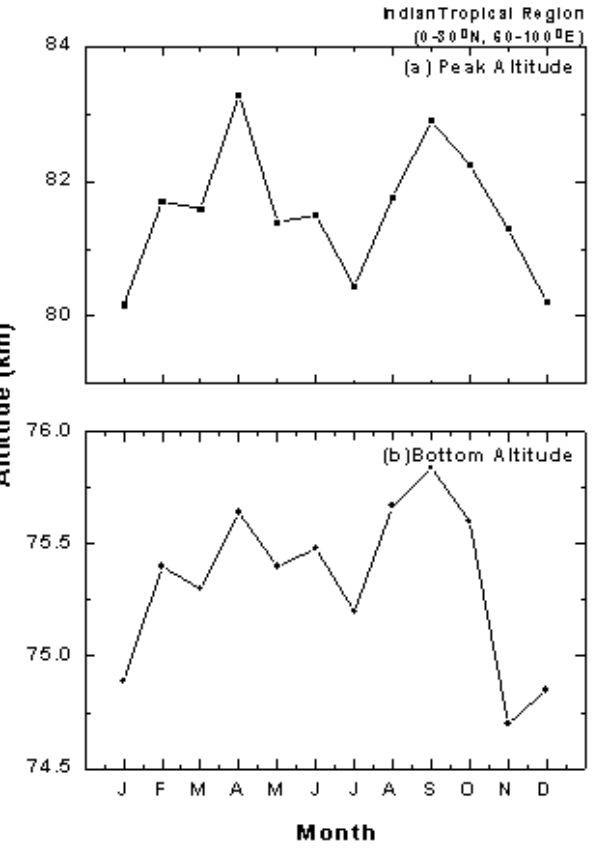
Fig. 4. Monthly variations of occurrence of ( a ) peak altitude and ( b ) bottom altitude of temperature inversions as obtained in this work using the HALOE temperature series over the Indian tropical region (0–30 ◦ N, 60–100 ◦ E) during the period